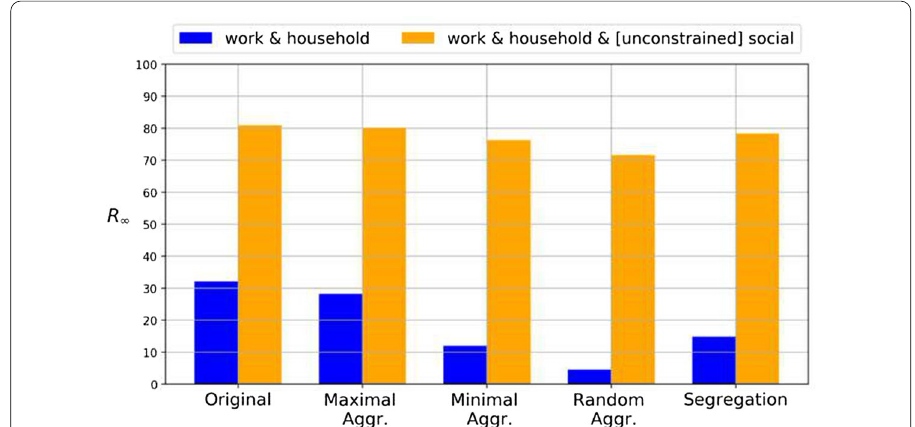
Fig. 6 Fraction of recovered agents, R ∞ , for different strategies. Here we compare a multiplex with only Work and Household layers (without Social layer) and a multiplex which includes also an unconstrained Social layer. The color strategies are for the case of 10 colors. Error bars are not plotted for being